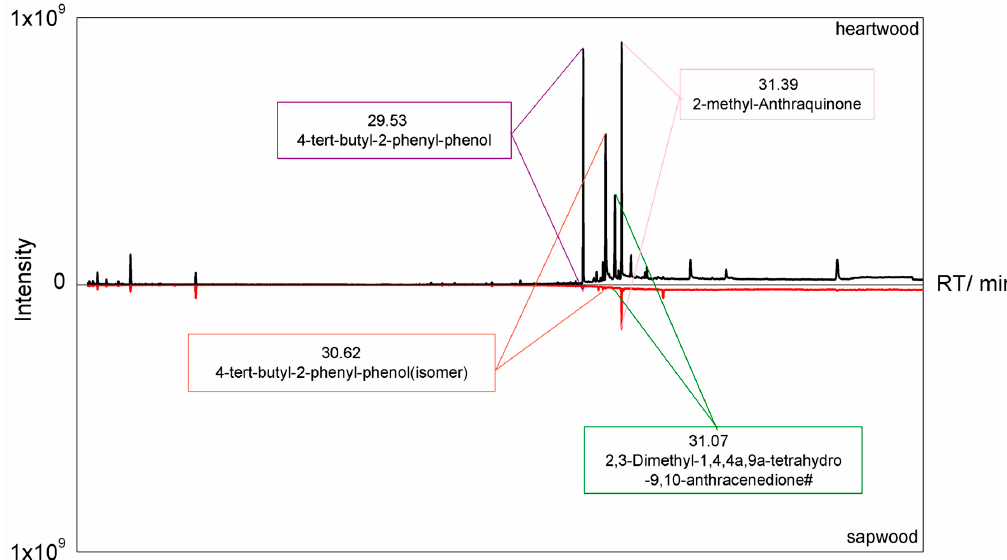
Figure 2. Gas chromatography–mass spectrometry (GC–MS) chromatogram of acetone extractive in the heartwood and sapwood of teak. Table 4. GC–MS analytical results of acetone extractive compounds in heartwood and sapwood of teak.